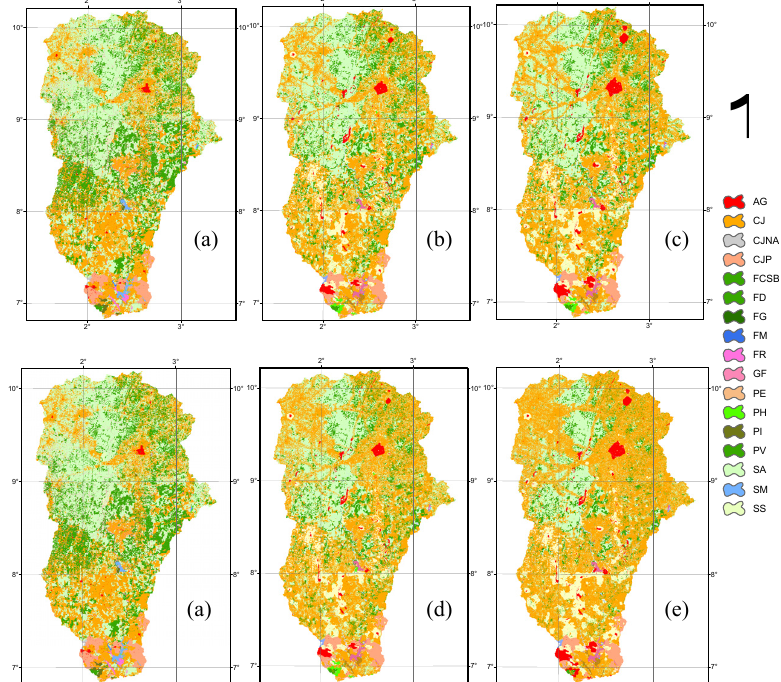
Figure 10. Land use/cover of the Ouémé-Bonou (49,256 km 2 ) and the Donga-Pont catchments (586 km 2 ). The legend is fully explained in Table 3. ( a ) reference map